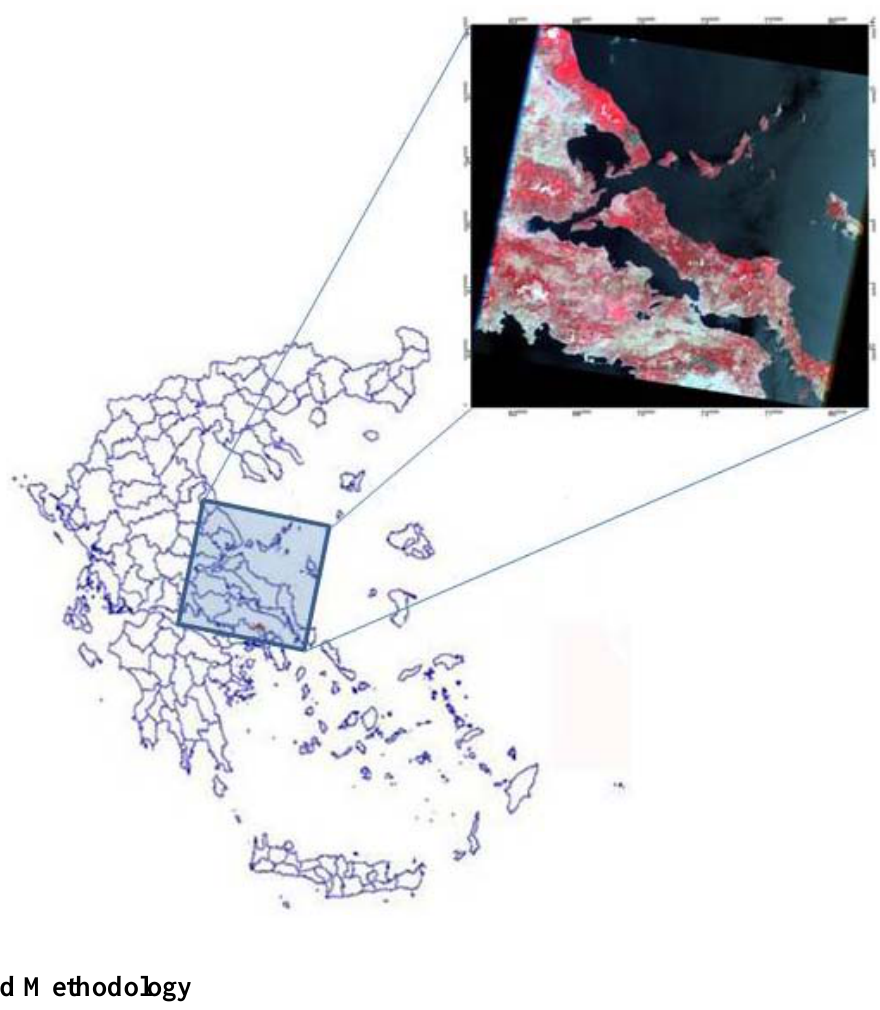
Figure 1. The location of the study site is shown on the left side of the map. The image on the right is the acquired false color composite Landsat TM scene (acquisition date: July 3 rd ,